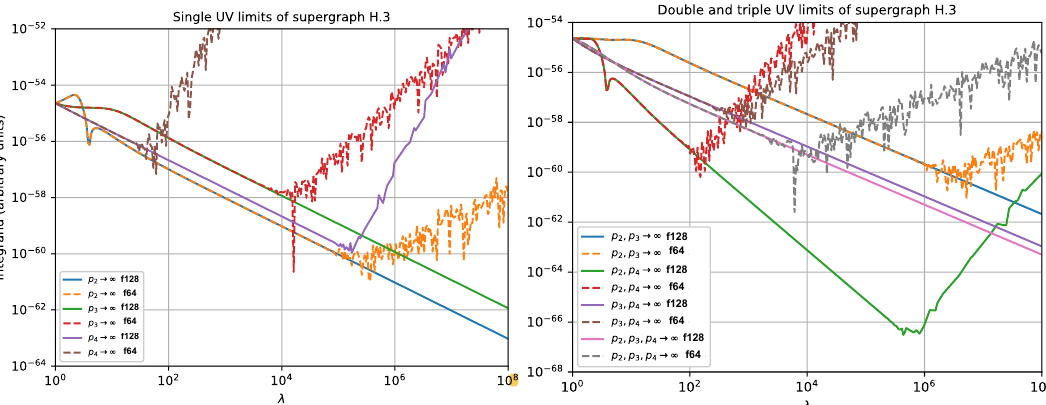
Figure 14. Behaviour of the LU integrand of supergraph H.3 of eq. (6.6) for each possible subset of momenta from the loop momentum basis { p to approach infinity. The UV scaling of the Minkowsi integration measure (i.e. dp included in the results shown. Solid lines correspond to evaluations in quadruple precision (f128) whereas dashed ones are evaluations in double precision